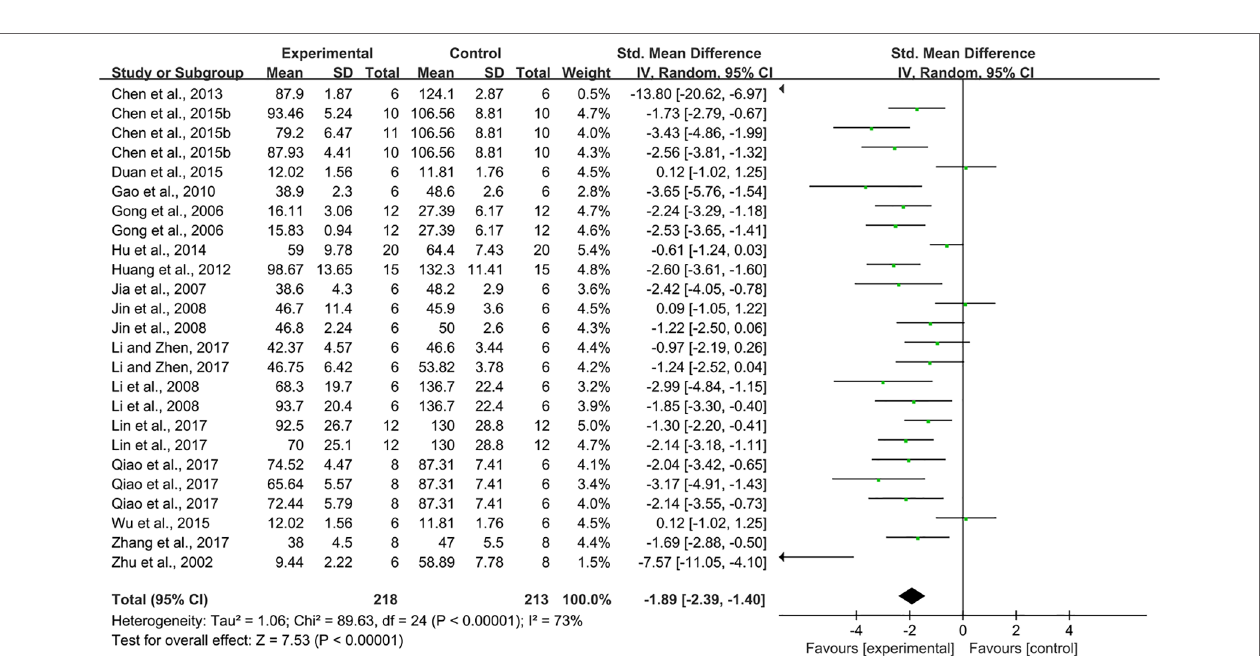
FiGURe 3 | Pooled estimate of Scr with